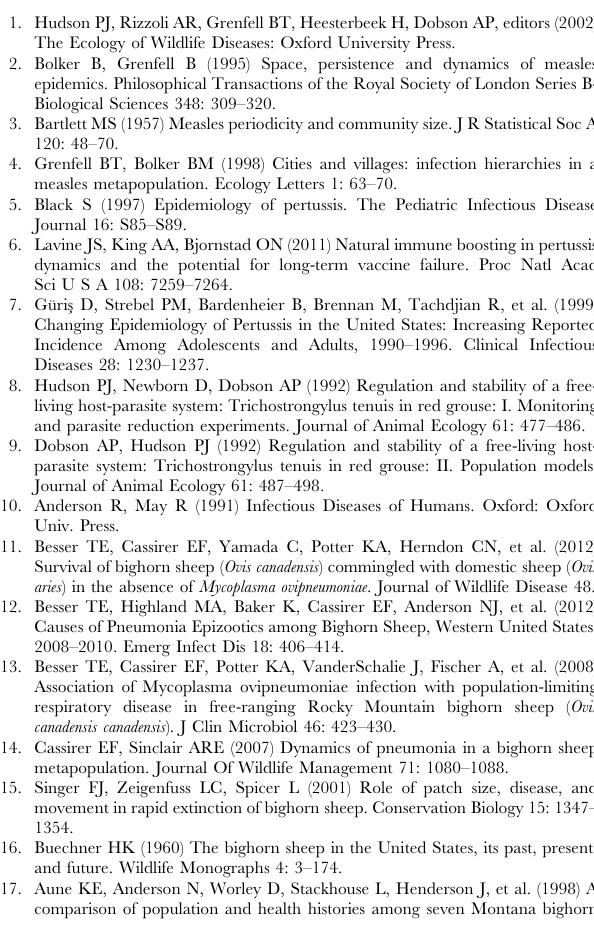
Figure S1 Data collection and pneumonia histories within Hells Canyon populations of bighorn sheep. A.